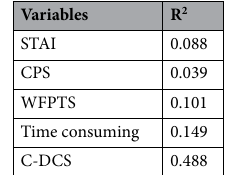
Table 8. The SMC R 2 of dependent variable (n =